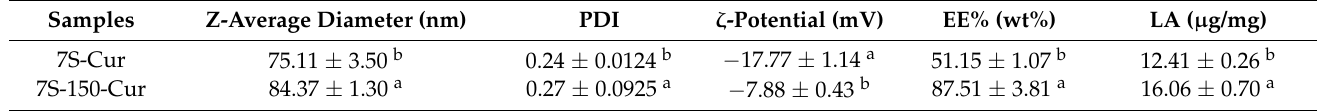
Table 2. The Z-average diameter, polydispersity index (PDI), ζ -potential, encapsulation efficiency (EE%), and loading amount (LA) of the 7S-Cur and 7S-150-Cur nanocomplexes prepared at 25 ◦ C.